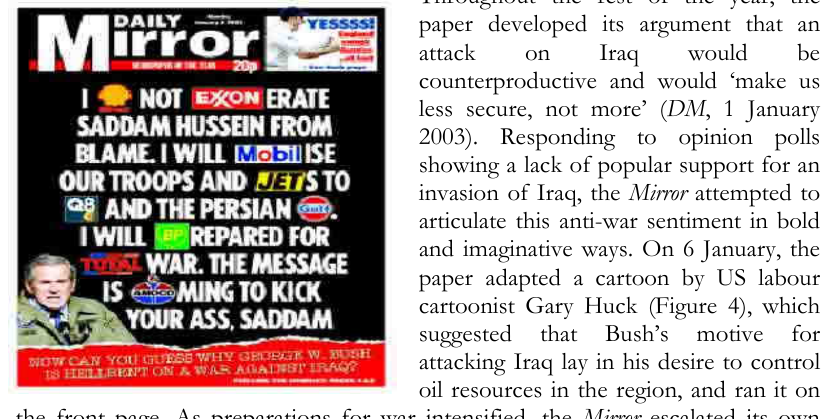
Figure 4. ‘I SHELL not EXXONerate Saddam